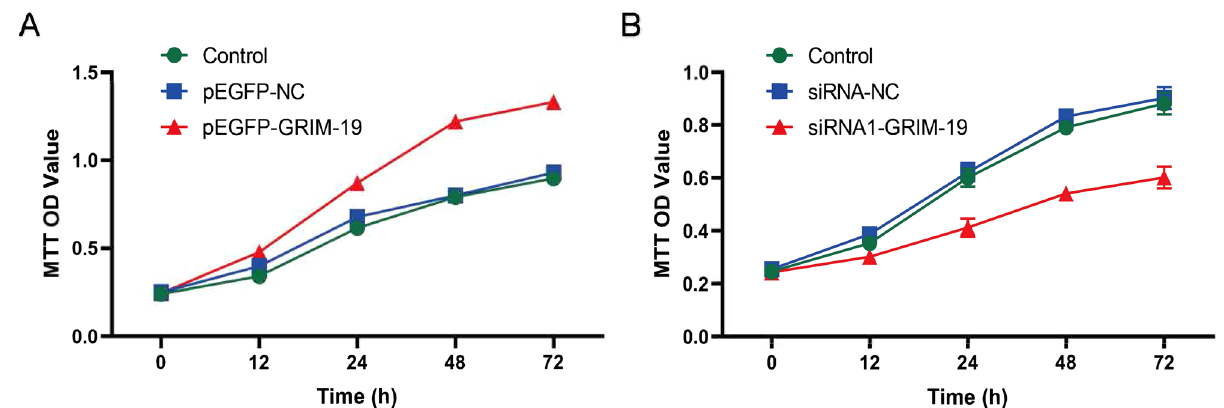
Figure 4. MTT measurement of cell proliferation. ( A ) Cell proliferations of pEGFP-NC and pEGFP- GRIM-19 cells at 0 h, 12 h, 24 h, 48 h, and 72 h after inoculation (0.478 ± 0.032vs.0.342 ± 0.023, 0.872 ± 0.034 vs 0.615 ± 0.032, 1.221 ± 0.021 vs 0.792 ± 0.022, 1.332 ± 0.041 vs 0.898 ± 0.035, P < 0.05). ( B ) Cell proliferations of siRNA-NC and siRNA-GRIM-19 cells at 0 h, 12 h, 24 h, 48 h, and 72 h after inoculation (0.301 ± 0.023 vs 0.353 ± 0.021, 0.372 ± 0.023 vs 0.601 ± 0.035, 0.443 ± 0.020vs 0.691 ± 0.021, 0.552 ± 0.041 vs 0.822 ± 0.039, P <